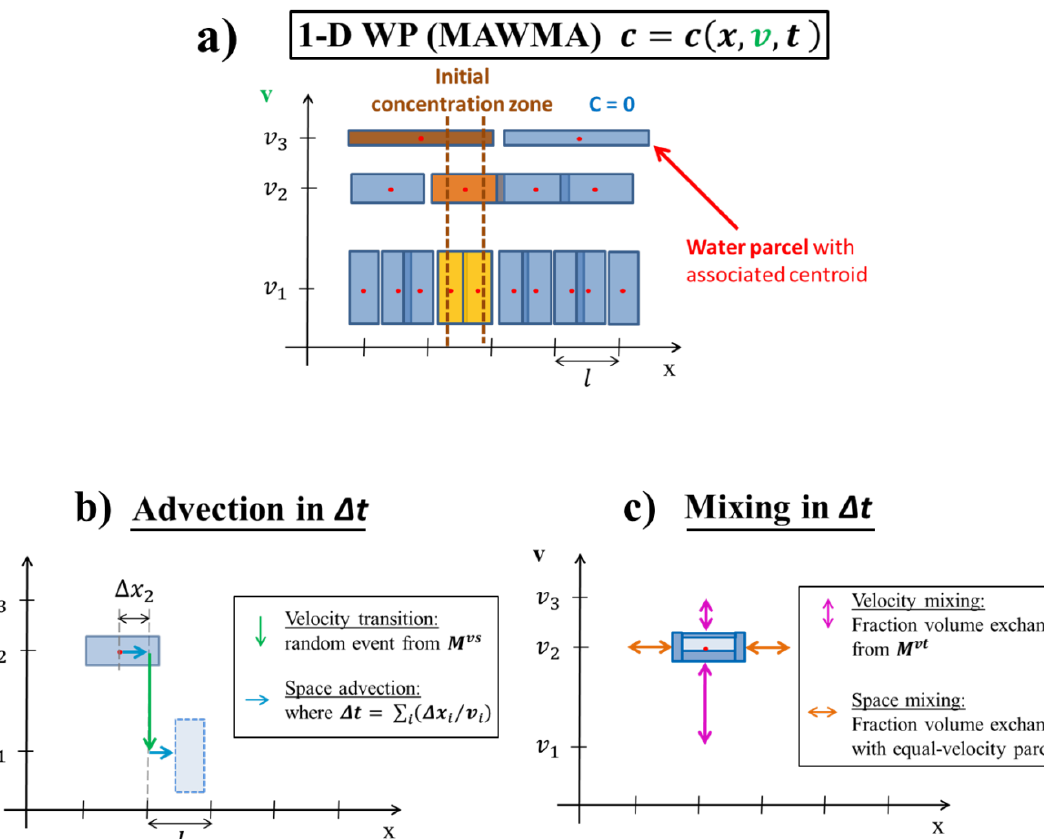
Figure 2. Scheme of water parcels (WP) method using the multi-advective water mixing approach formulation with three velocity classes: ( a ) initial distribution of parcels in the ( x,v ) domain and the initial concentration condition, ( b ) advective process for a single water parcel, and ( c ) mixing process for a single water parcel.